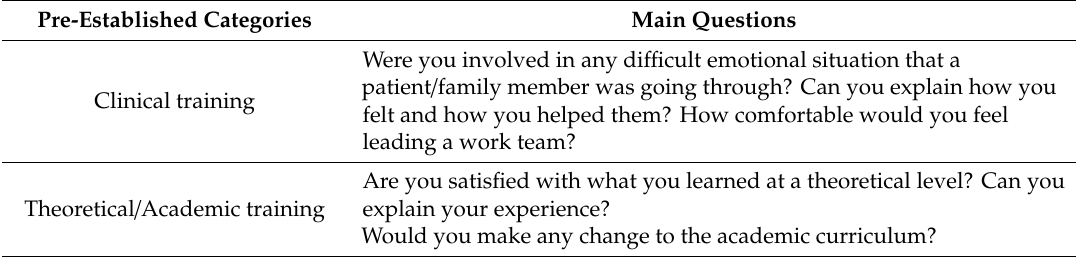
Table 3. Main questions in the interview guide for focus groups (FGs).